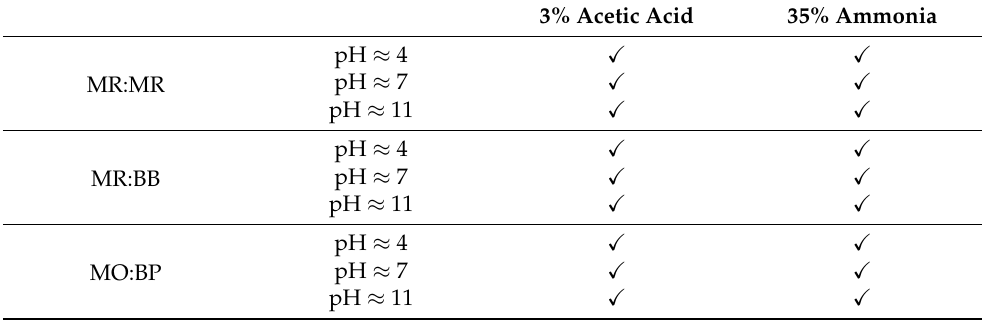
Table 1. Sensitivity of filter paper dyed with pH-sensitive aqueous solutions to 3% ( v / v ) acetic acid and 35% ammonia. The pH-sensitive solutions used were prepared at different pH 4, 7 and 11, and consisted of different combinations: methyl red and methyl red sodium salt (MR:MR); methyl red and bromothymol blue (MR:BB); methyl orange and bromocresol purple (MO:BP). 3% Acetic